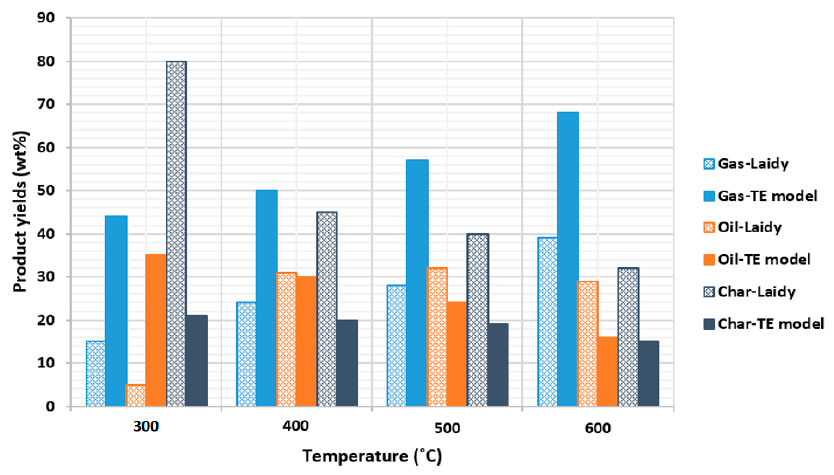
Figure 6. Comparison of product yields (wt%) for bamboo.